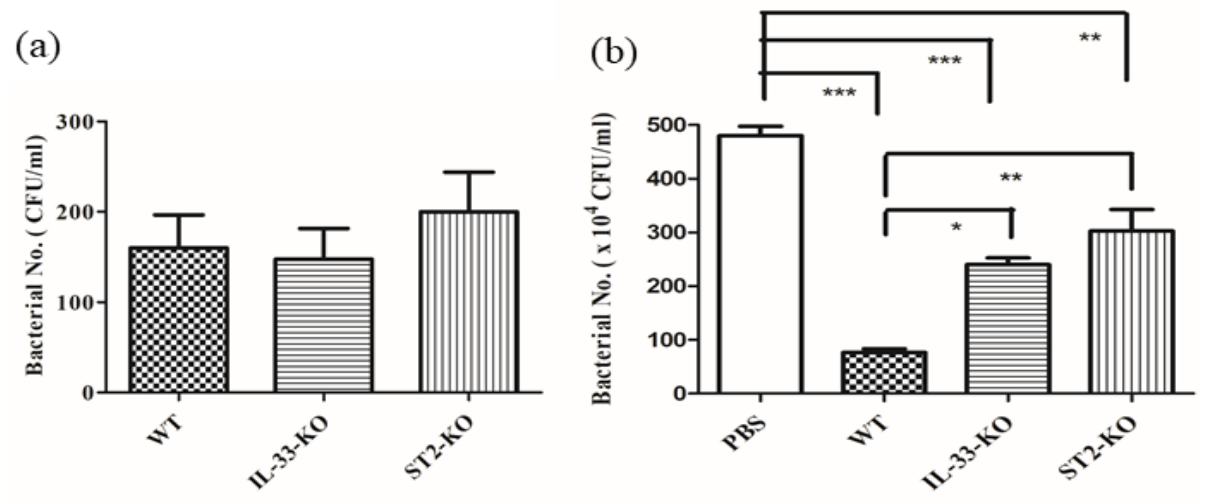
Figure 6. The phagocytosis activity and the bactericidal activity of neutrophils collected from WT, IL - 33 -KO, and ST2 -KO mice. Bone marrow neutrophils (1.5 × 10 6 cells) from WT, IL - 33 -KO, and ST2 -KO mice were infected with GAS NZ131 cells at MOI of 0.01 for 30 min at 37 ◦ C using a rotating mixer. After that, the extracellular bacteria were eliminated using RPMI medium containing gentamicin at 37 ◦ C for 30 min. ( a ) After several washes by RPMI medium, the cells were lysed and intracellular viable bacteria were quantified by plating on THY agar. The bacterial numbers presented on this timepoint represent the phagocytosis of neutrophils. ( b ) Bone marrow neutrophils (1.5 × 10 6 cells) from WT, IL - 33 -KO, and ST2 -KO mice were infected with GAS NZ131 cells at MOI of 0.01 for 4 h at 37 ◦ C using a rotating mixer. The remaining viable bacteria were counted, representing the bactericidal activity of neutrophils. Treatment groups were compared for significance using ANOVA. * p < 0.05, ** p < 0.01, *** p < 0.001 compared with the relative group as shown in the figure.